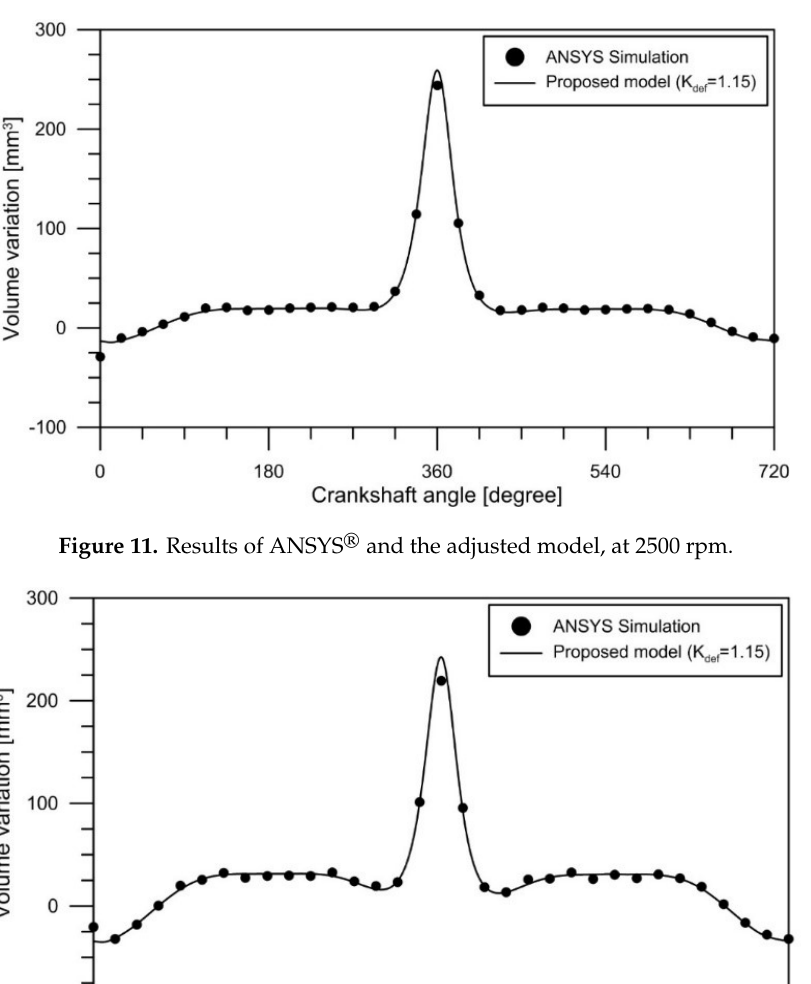
Figure 10. Results of ANSYS ® and the adjusted model, at 1500 rpm.